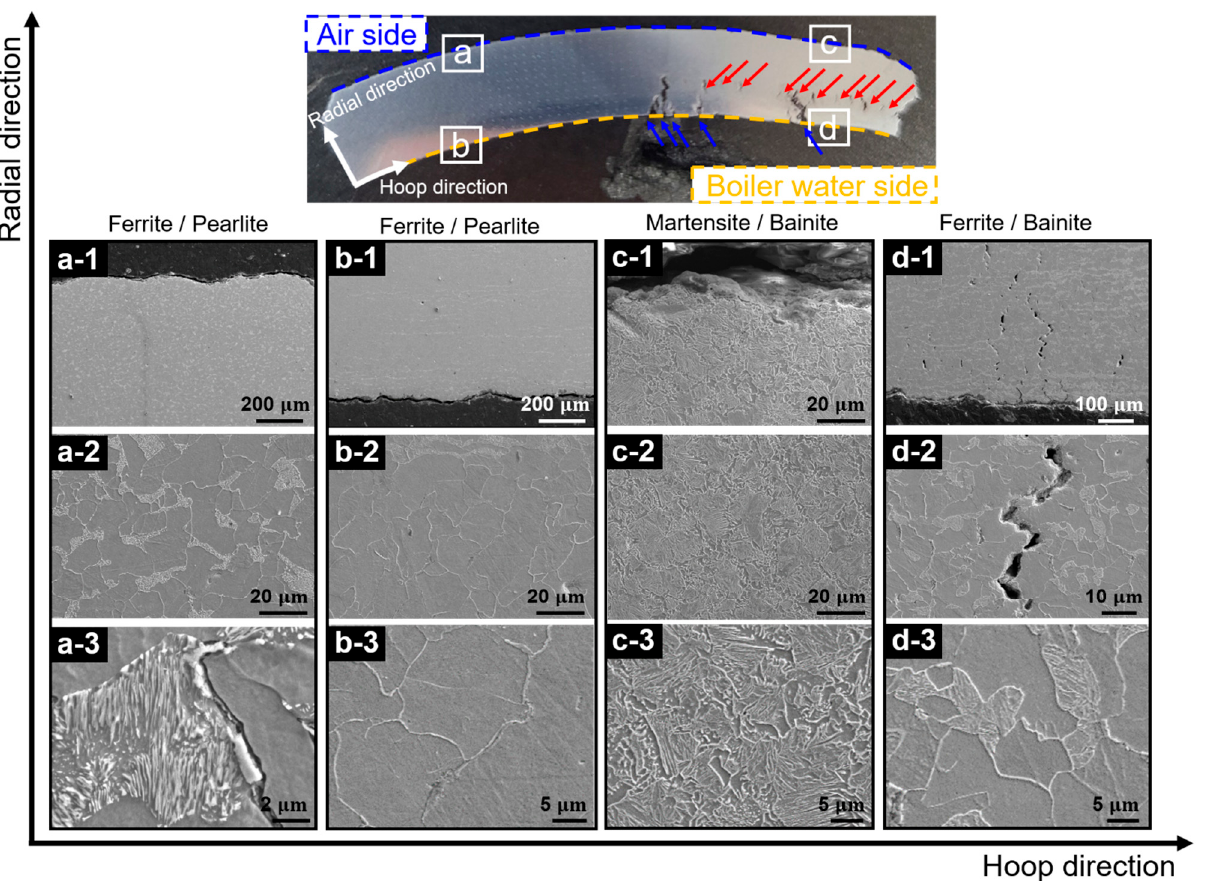
Figure 5. SEM images of the damaged (fractured) tube: ( a-1 , a-2 , a-3 ) images in the air side, ( b-1 , b-2 , b-3 ) images in the boiler water side, ( c-1 , c-2 , c-3 ) images in the air side of the overheated zone and ( d-1 , d-2 , d-3 ) images in the boiler water side of the overheated